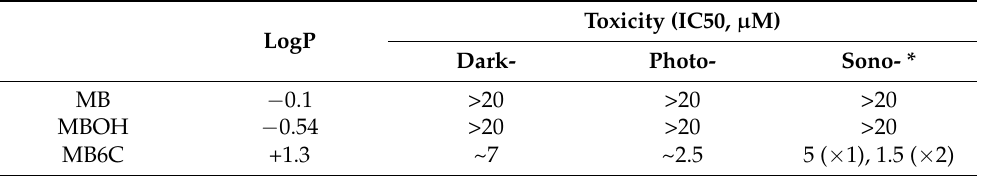
Table 1. LogP (octanol: buffer partition coefficients) values, dark-, photo- and sonotoxicities of the phenothiazine derivatives after 12 h incubation in A549 cancer cells. Toxicity (IC50, µ M) LogP Dark- Photo- Sono- * MB − 0.1 >20 >20 >20 MBOH − 0.54 >20 >20